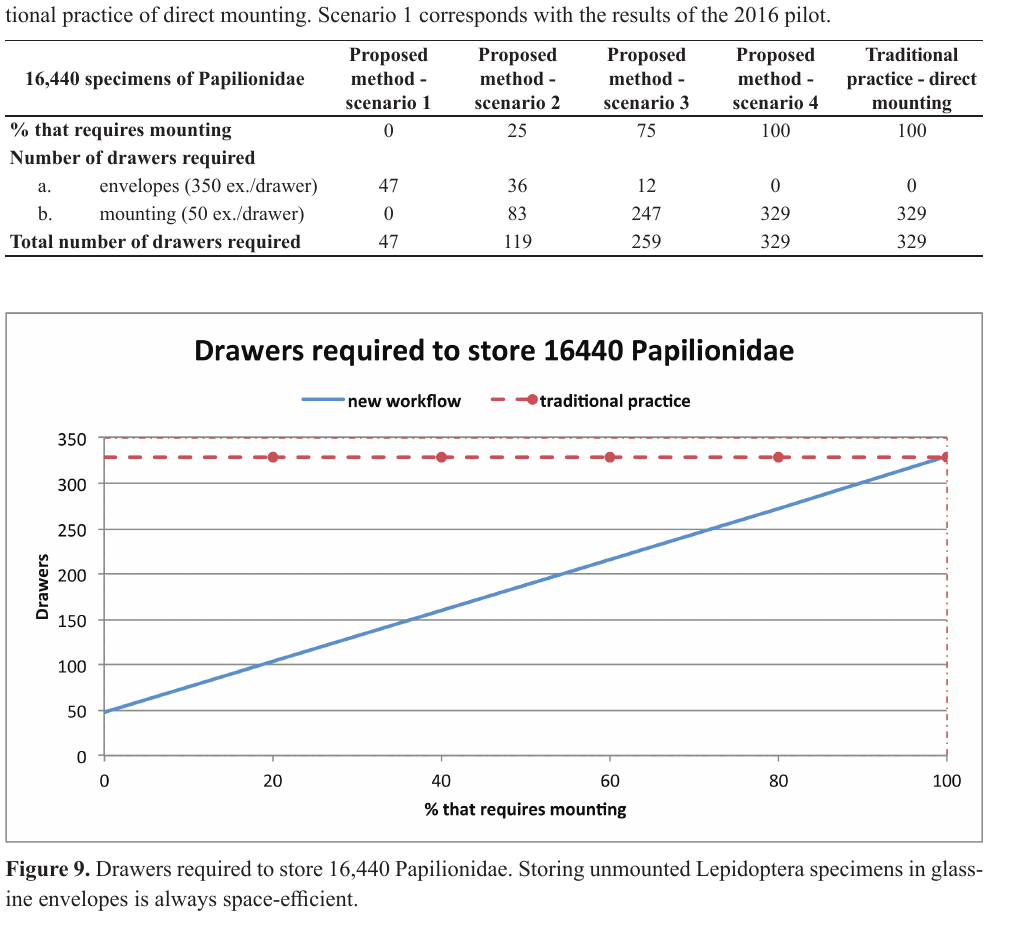
ine envelopes is always space-efficient.